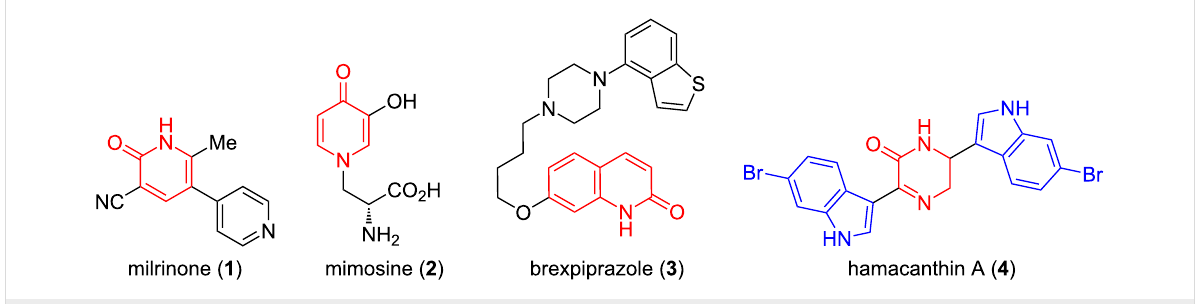
Figure 1: Bioactive compounds with pyridinone, quinolone and indole cores.